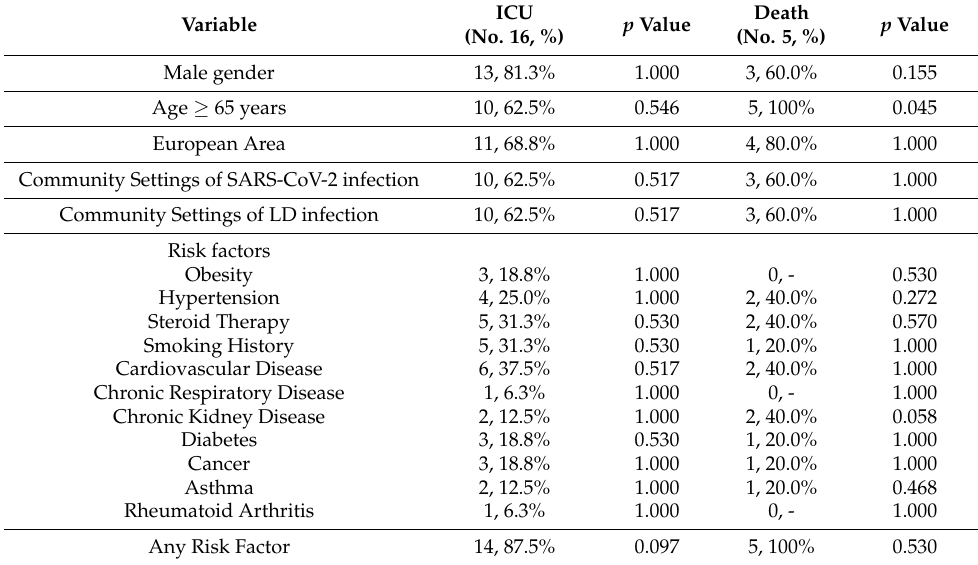
Table 5. Association of the characteristics of individual cases of SARS-CoV-2 and Legionella co- infections with the outcome of being admitted to an intensive care unit (ICU) and death. P-value from Fisher’s exact